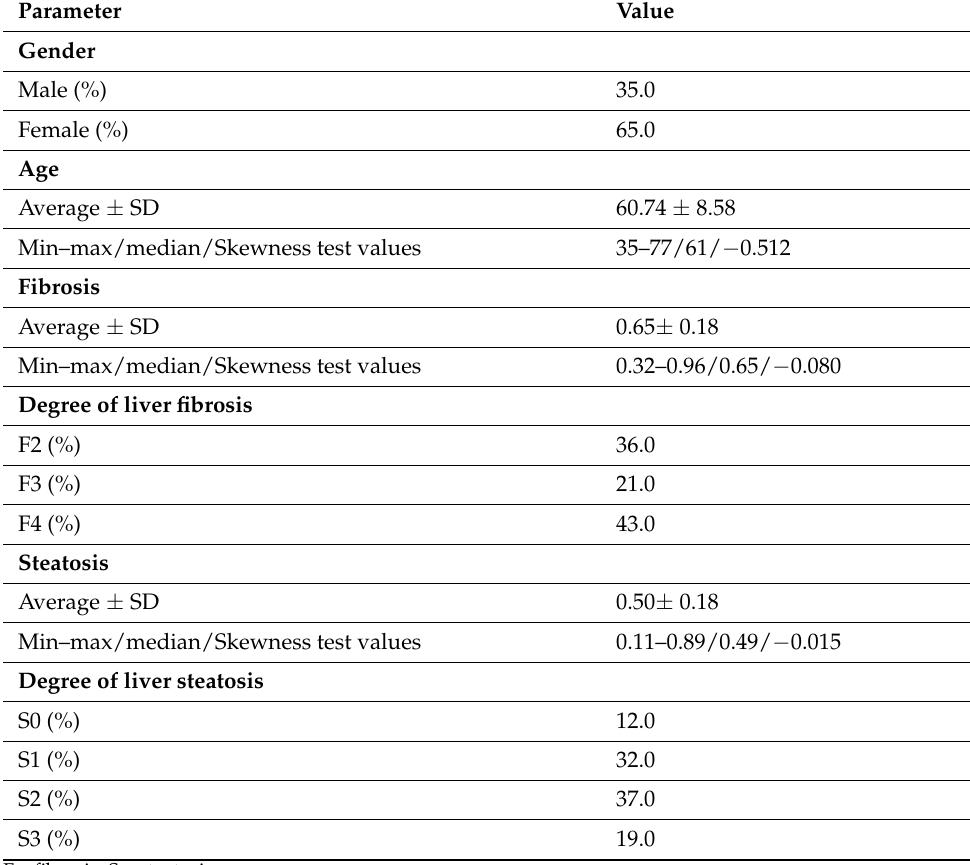
Table 1. Baseline characteristicsof the entire study population.